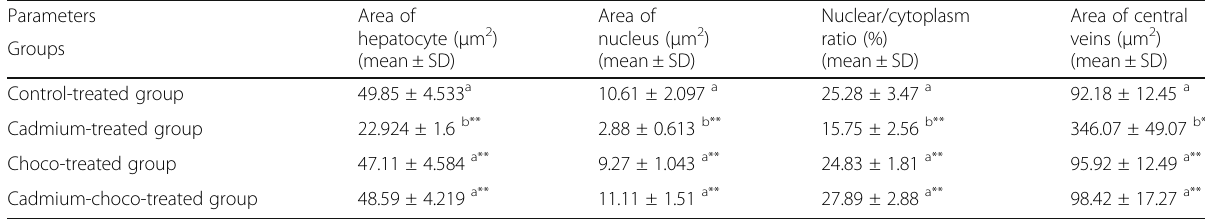
Ten animals were used in each group. Data are represented as mean±SD Means with the same letter are not significantly